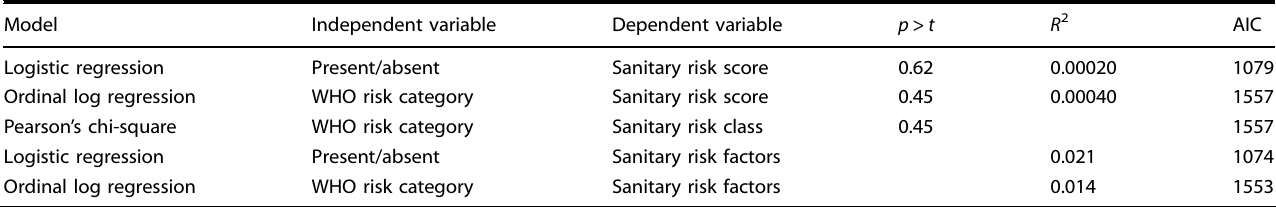
Table 1. Results of previous models showing no signi fi cant association between sanitary risk score and water quality analysis — AIC values show that logistic regression is the model with the best fi